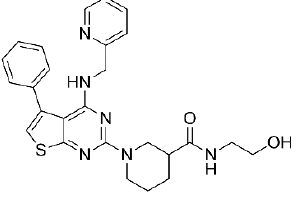
Figure 3. Structure of XEN-D0101. DPO-1 (Diphenylphosphine oxide, Figure 4). DPO-1 blocks I Kur rate-dependently at